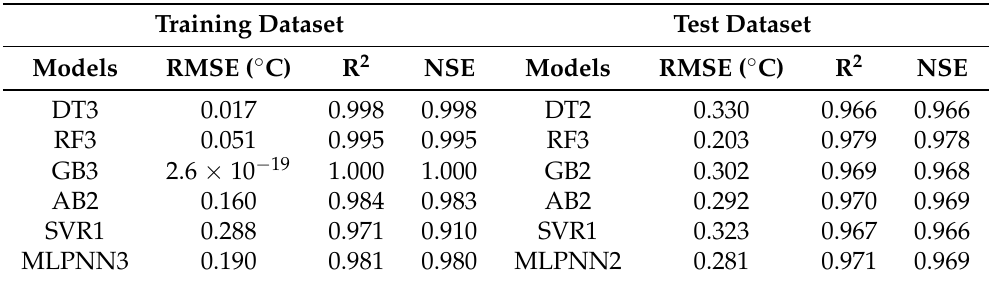
Table 8. Best version of performance in different models (DT: decision trees, RF: random forests, GB: gradient boosting regression, AB: adaptive boosting regression, SVR: support vector regression, and MLPNN: multilayer perceptron neural networks) in predicting water temperature (WT: ◦ C), 1.only one input variable (DOY), 2. with two input variables (DOY and Flow), 3. with all